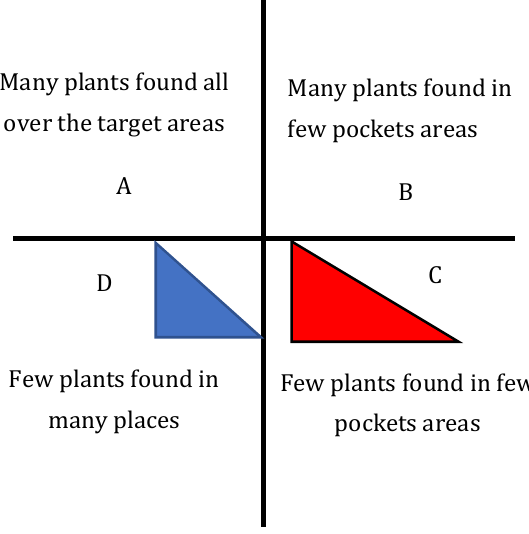
Figure 4. Four-cell analysis showing the status of MPs in the study areas. None of the sampled MPs are in quadrant (( A )–many plants found all over the sampled areas) and quadrant (( B )–many plants in few pocket areas). However, most of the MPs identified by the current study were categorized in quadrant (( C )–few plants growing in few pocket areas), the red triangle. This imply that these MPs are under the threat of extinction. The blue triangle in quadrant (( D )–few plants dispersedly cover- ing wider areas) shows few MPs growing in few pocket areas.